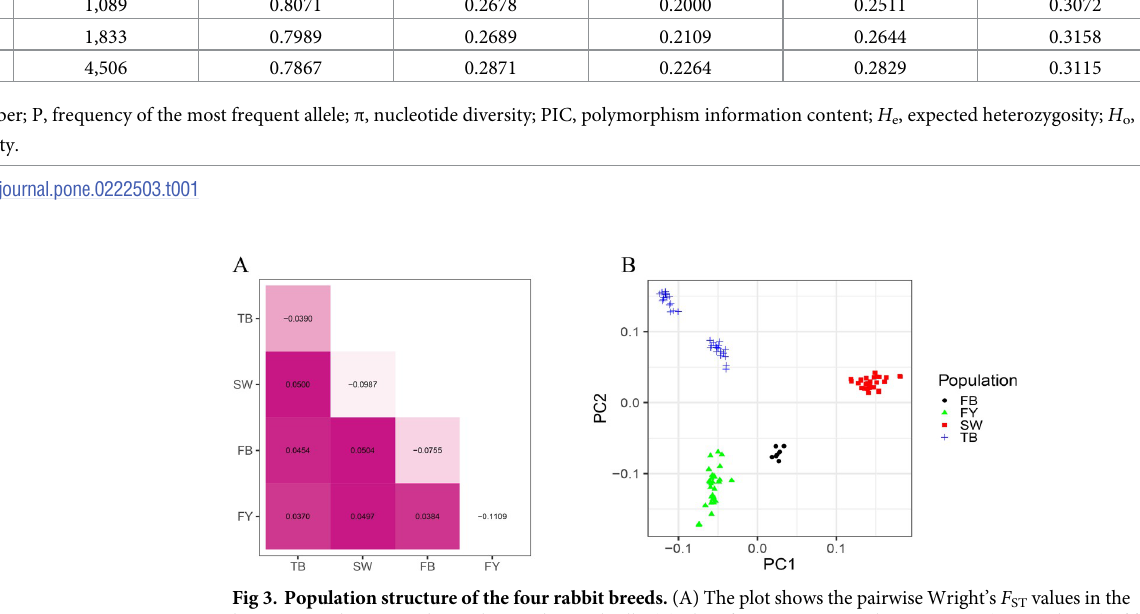
S1 Table. Sequencing and quality filtering of reads.